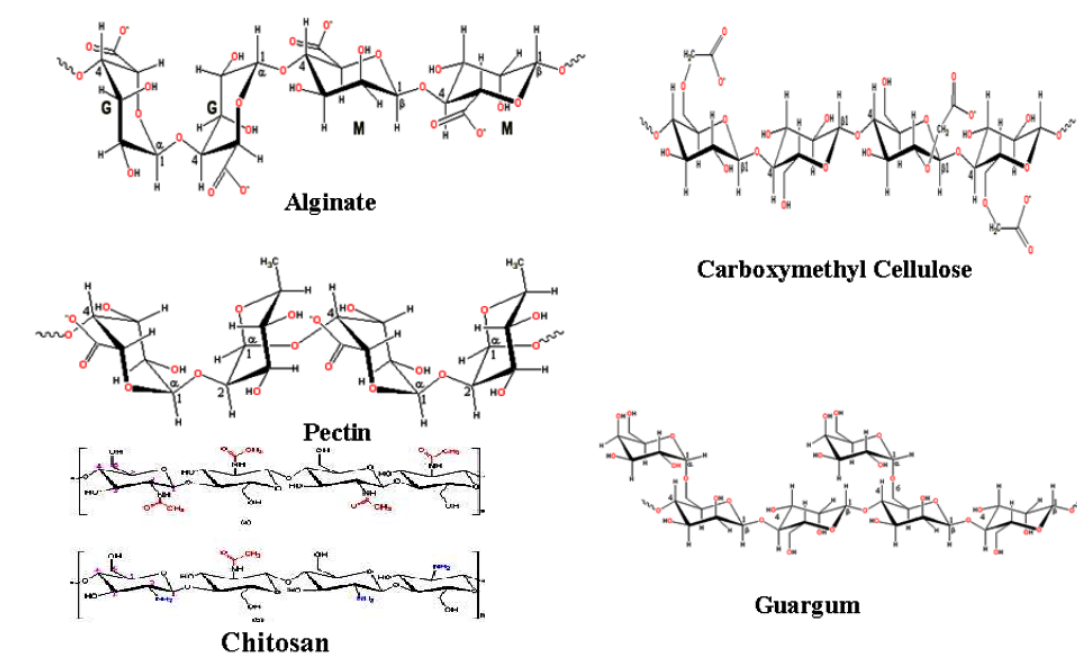
Figure 6. Selected biodegradable polymers commonly used for pesticide controlled release.